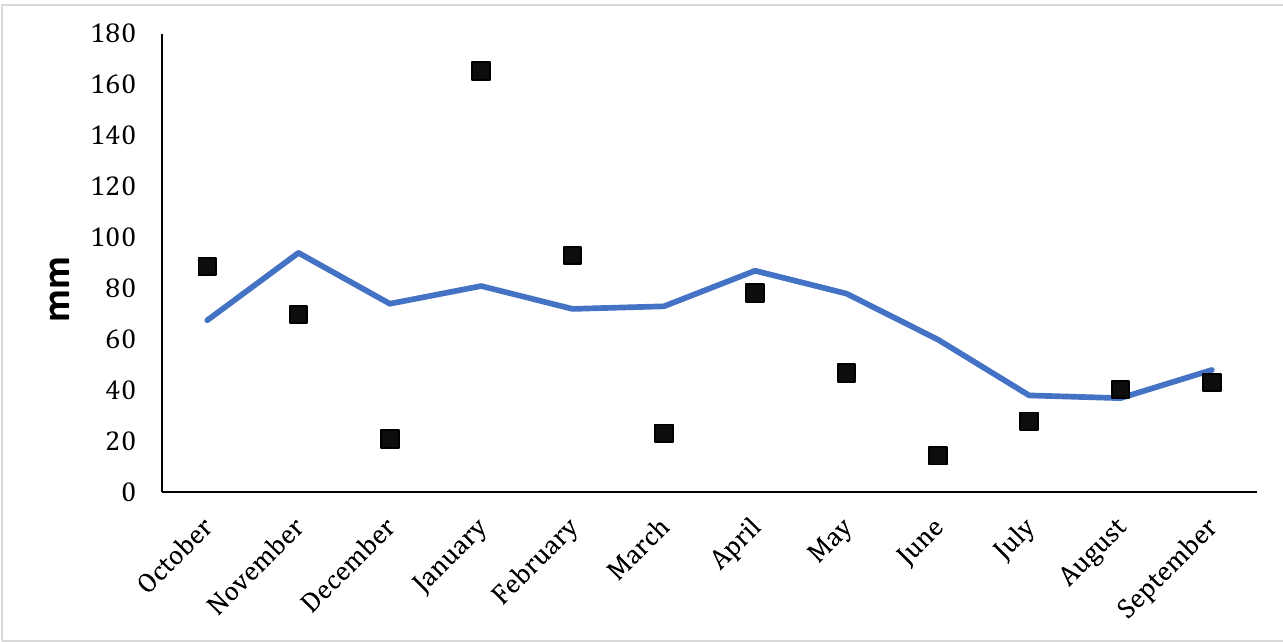
Figure 2. Vitoria-Gasteiz climatic station water precipitation regime. The blue line shows the average precipitation (mm) for the last 30 years (1989–2018). The black dots indicate 2018/2019 monthly precipitation (mm).